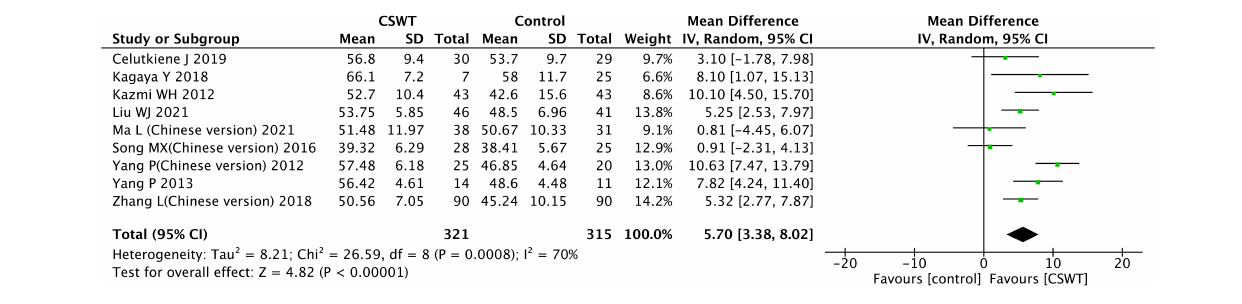
FIGURE4 Forest plot of the CSWT group vs. the control group-LVEF.